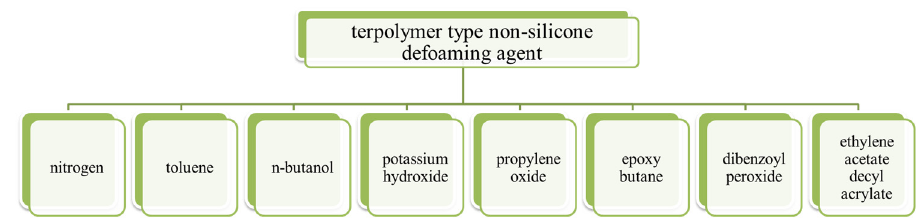
Figure 11. Raw materials for the preparation of a terpolymer-type non-silicone defoaming agent. Yujuan Chen et al. [42] invented a non-silicone defoaming agent and its preparation method. Vegetable oil and its derivatives were used as the supporter, and silica and fatty acid metal soap were used as the main defoaming substances. Because the fatty acid